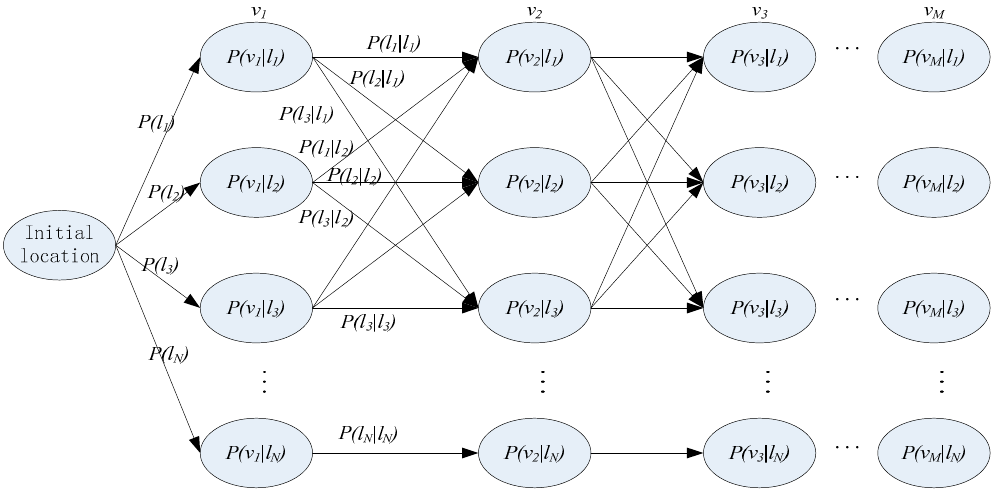
Figure 5. The trellis of the RSSI variation trends and the location transition.